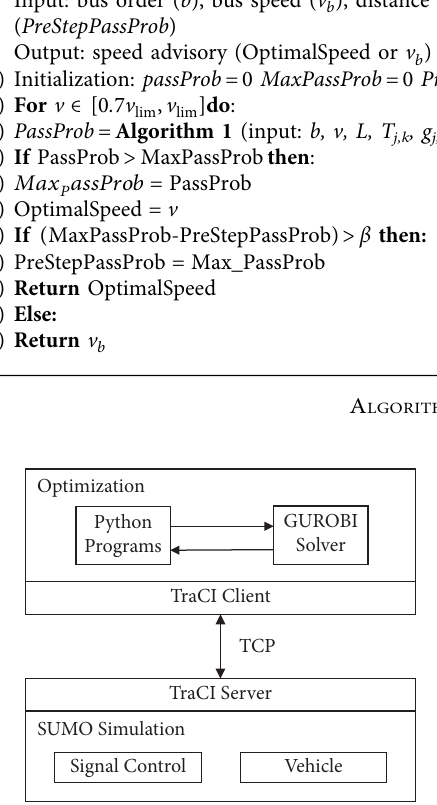
Figure 9: Integration of signal optimization and traffic simulation by